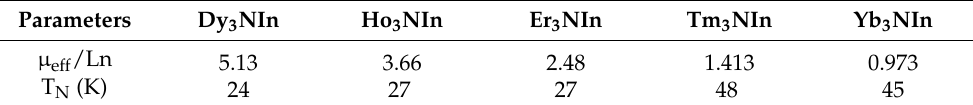
Table 3. Calculated values of magnetic moments per Ln atom in units of ( µ B ) of the anti-perovskite lanthanide nitrides Ln 3 NIn (Ln =